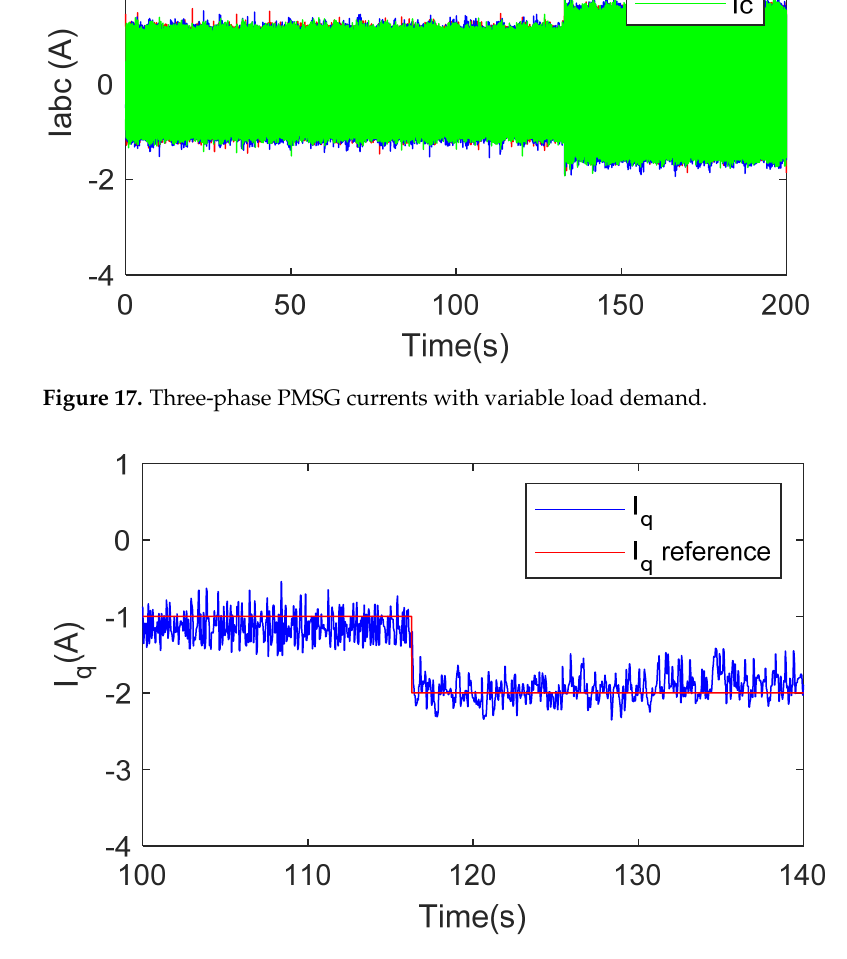
Figure 18. i q current control result with a variable reference.